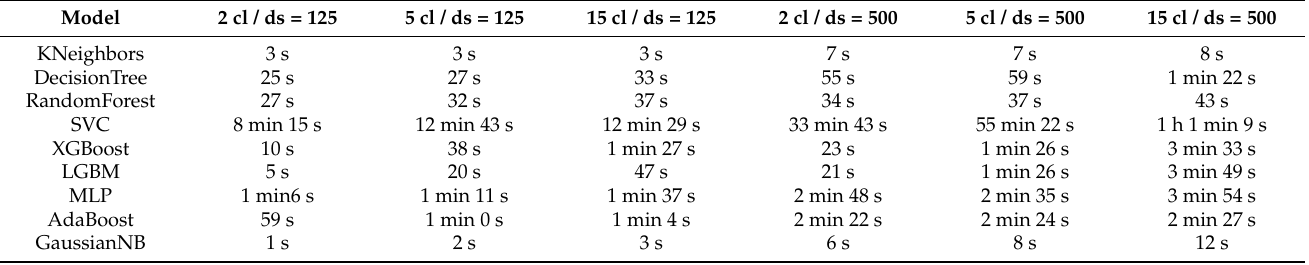
Table A3. Measured computation times for classifier models for 2, 5, and 15 classes and dictionary size (ds) = 125 and 500